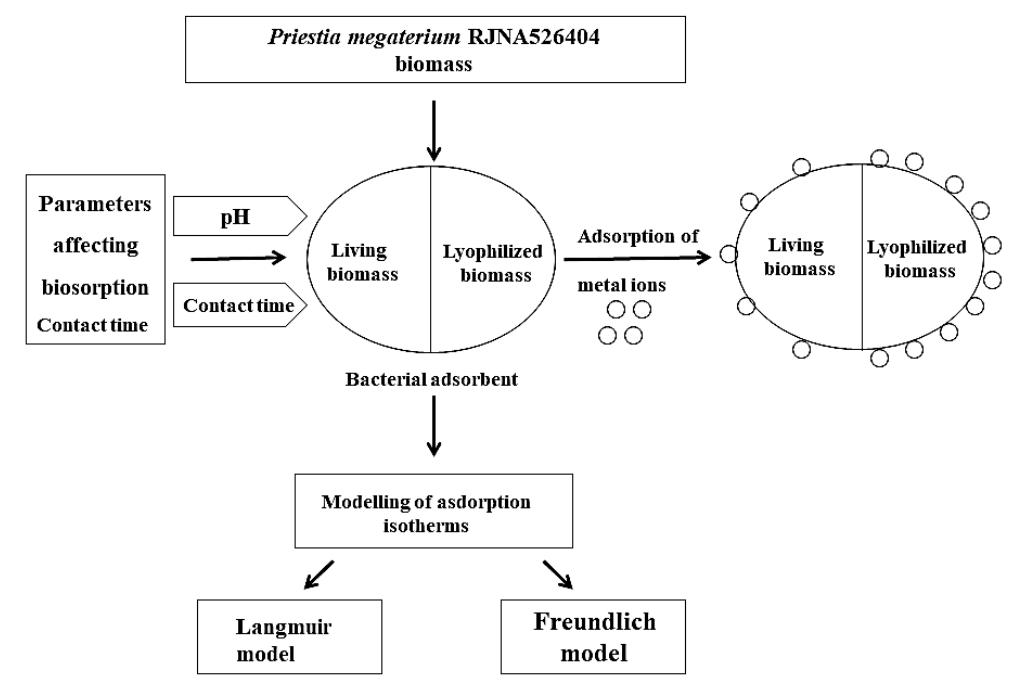
Figure 8. Schematic illustration of Priestia megaterium PRJNA526404 biomass preparation and ad- sorption procedure.